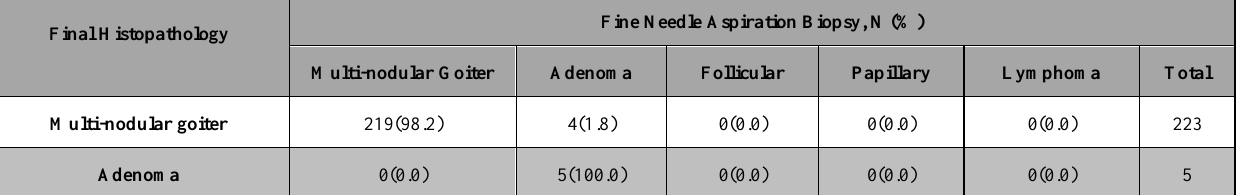
Table 2. The correlation between fine needle aspiration biopsy and final pathology results (N=